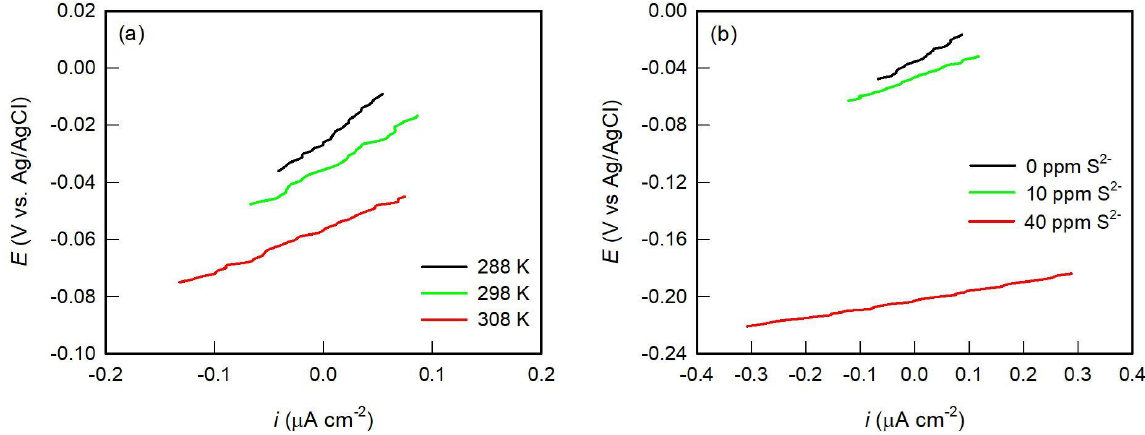
Figure 5. Linear parts of polarization curves for AISI 316L stainless steel in seawater at different ( a ) temperatures and ( b ) S 2− concentrations (at 298 K).